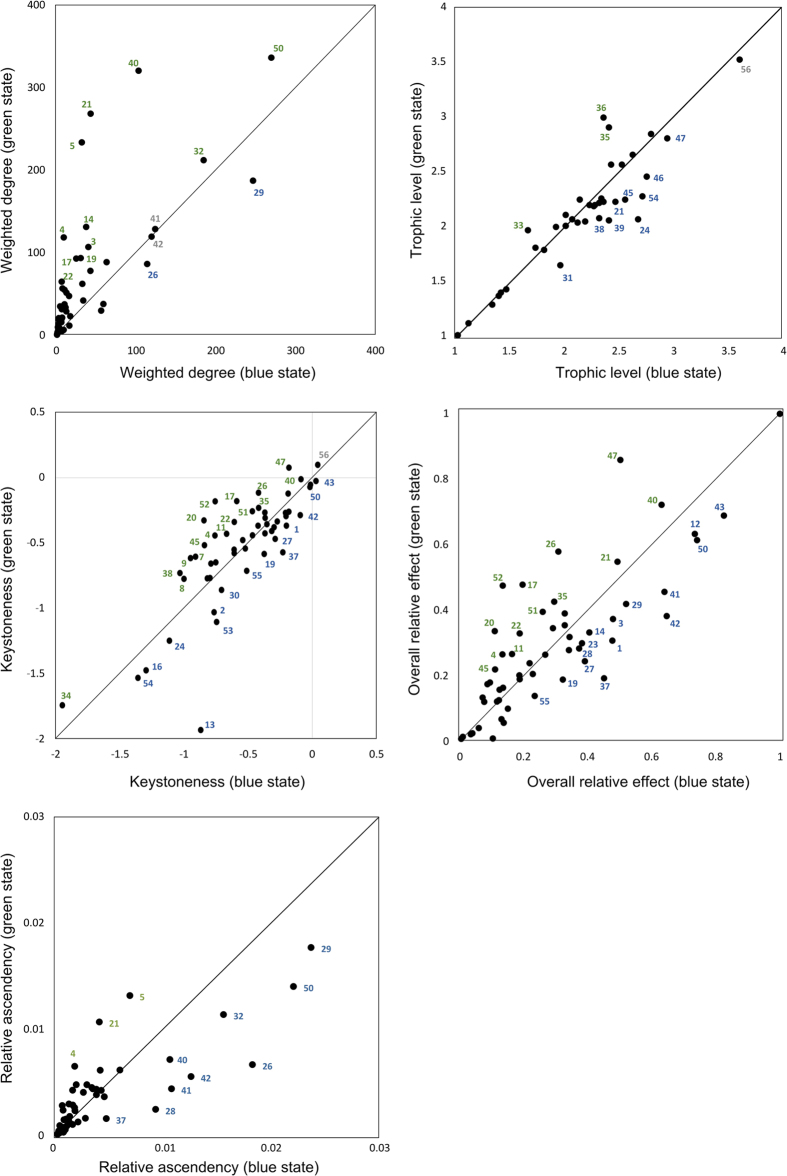
Comparison between food-web indicators in the green and blue webs (on the y and x axes, respectively).Numbers refer to FNs’ codes. Those FNs showing a relatively higher value for a food-web indicator in one of the two webs are either green- or blue-colored.